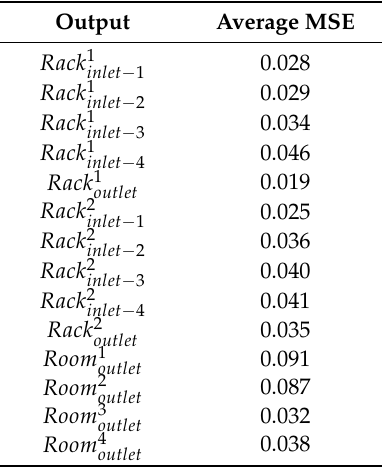
Table 3. MSE of simulation outputs for the tested scenarios.